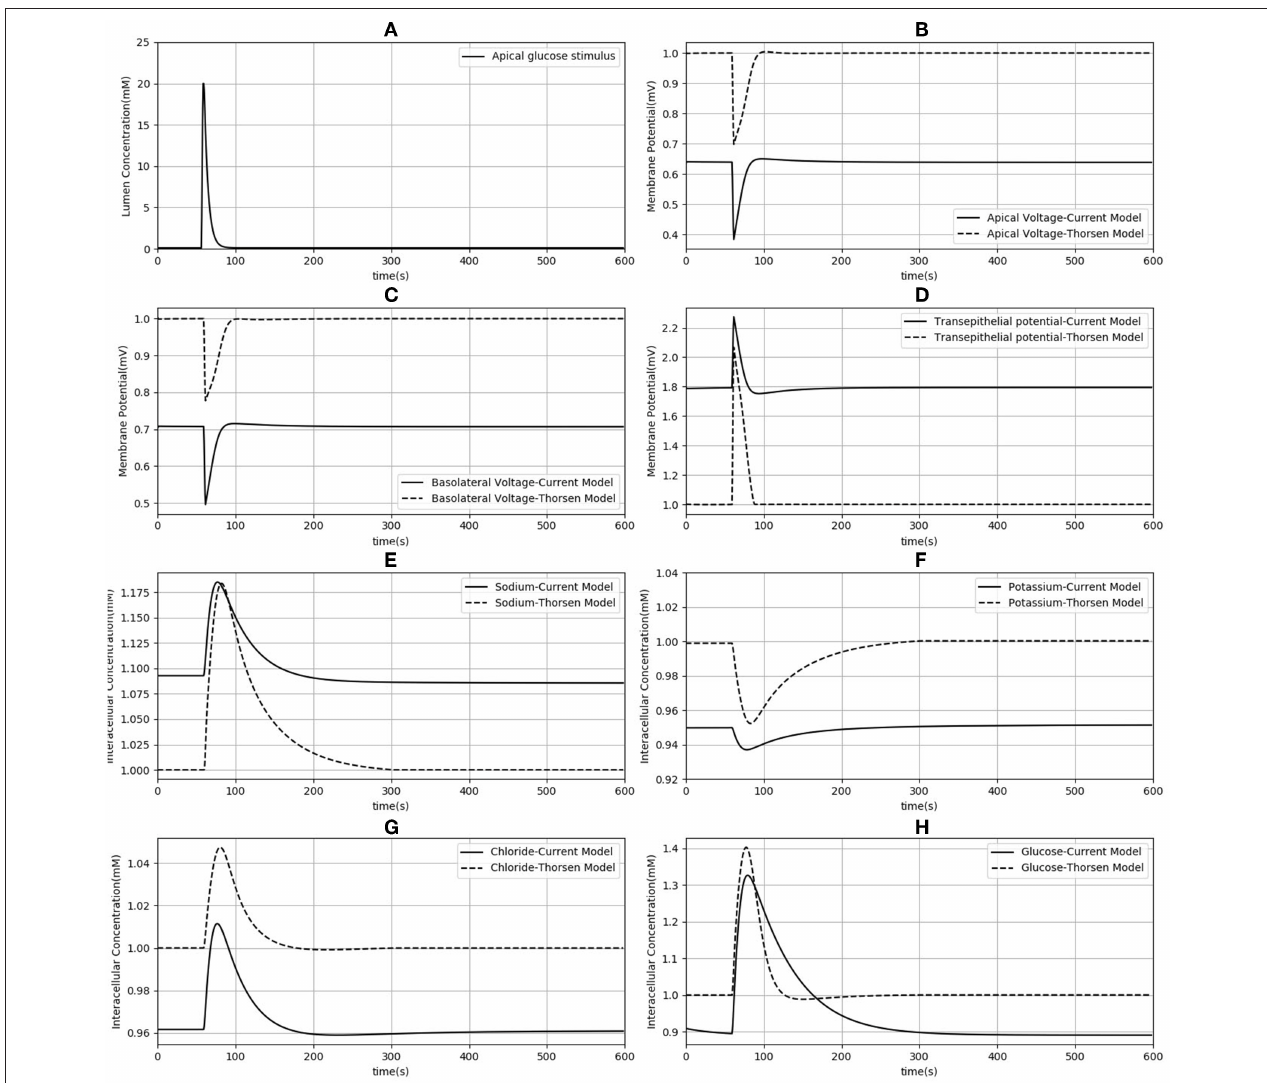
FIGURE 4 | Comparison of model responses against the model of Thorsen et al. (2014). Each variable has been normalized against the corresponding steady value from the Thorsen model. (A) Apical glucose stimulus. (B,C) Apical and basolateral membrane potential respectively. (D) Transepithelial potential. (E–H) Sodium, potassium, chloride and glucose intracellular